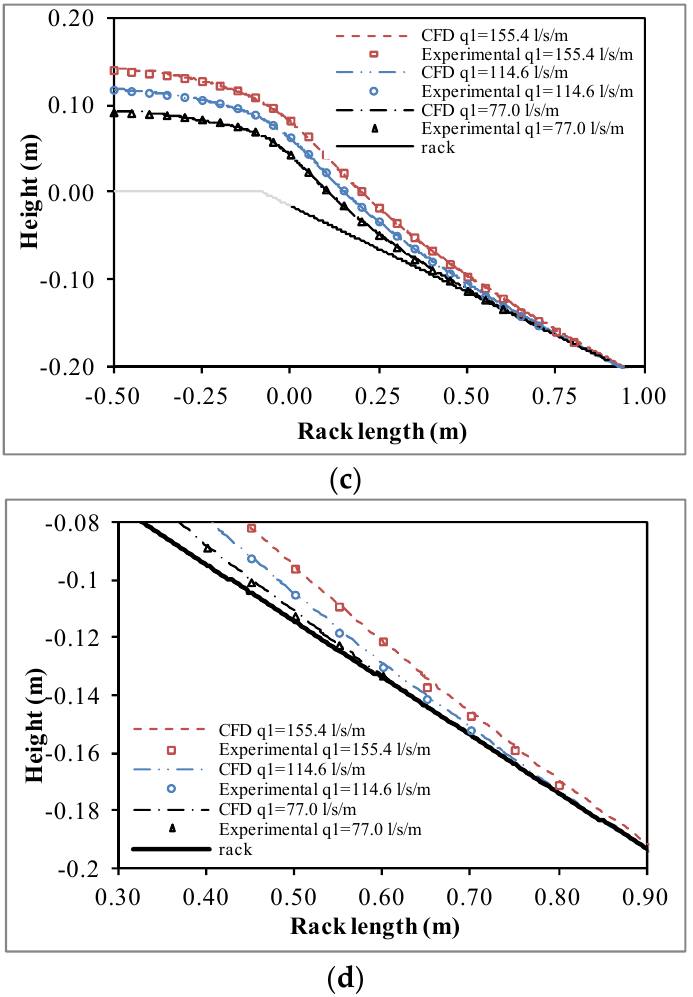
Figure 5. Flow profiles over a bar measured and simulated with computational fluid dynamics (CFD), for horizontal and 20% slope cases, with q 1 = 77.0, 114.6 and 155.4 l/s/m, in the rack C ( m = 0.28). ( a ) and ( b ) Rack with slope of 0% ; ( c ) and ( d ) Rack with slope of 20%.